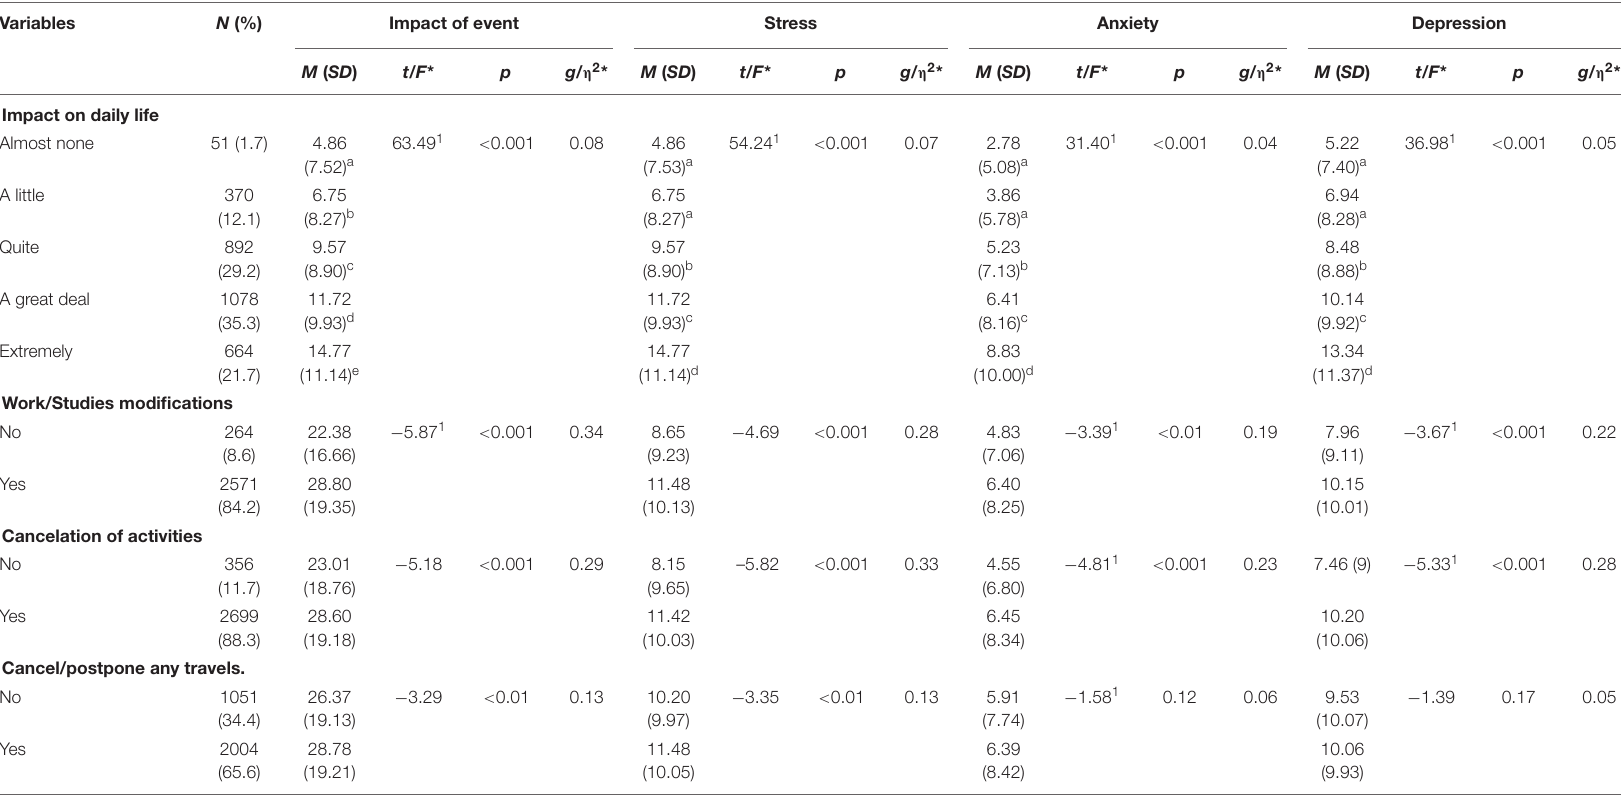
TABLE 6 | Association between the presence of significant changes in daily life due to the COVID-19 pandemic and the psychological impact of the COVID-19 pandemic as well as mental health status during the pandemic ( N = 3055). Variables N (%) Impact of event Stress Anxiety Depression